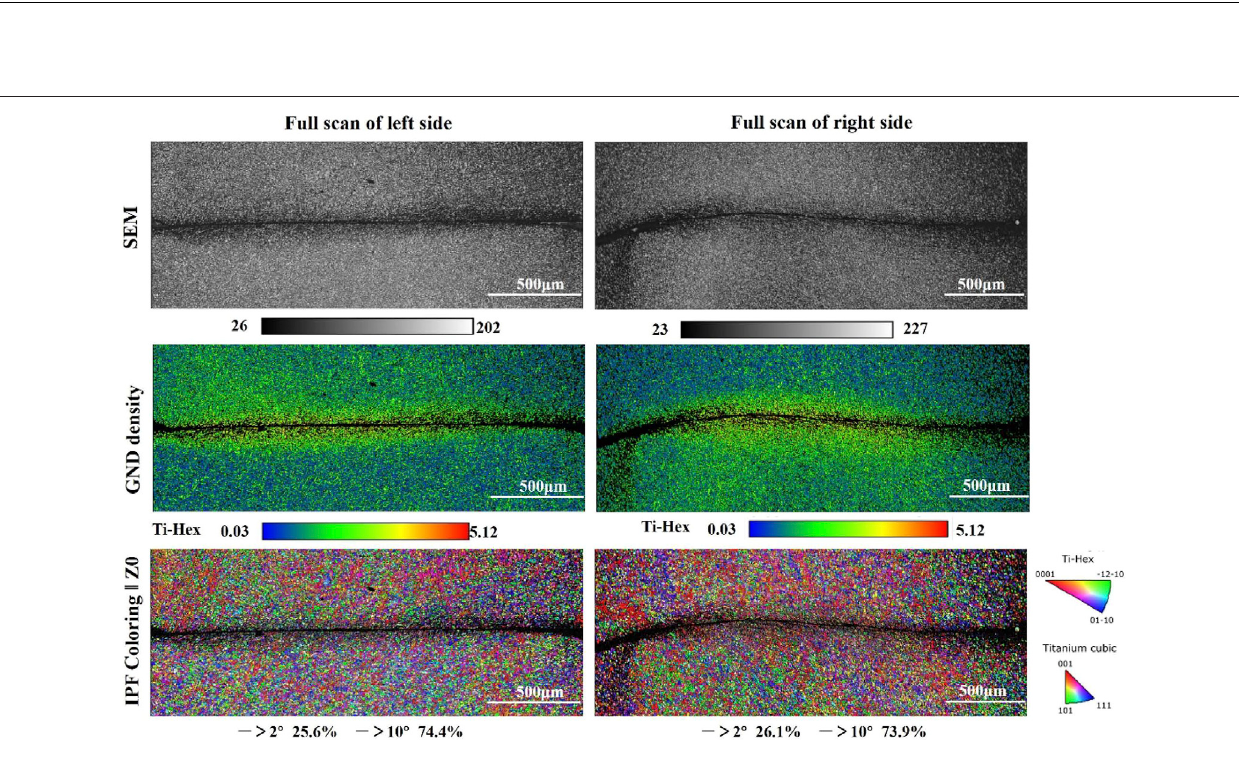
Frontiers in Materials |